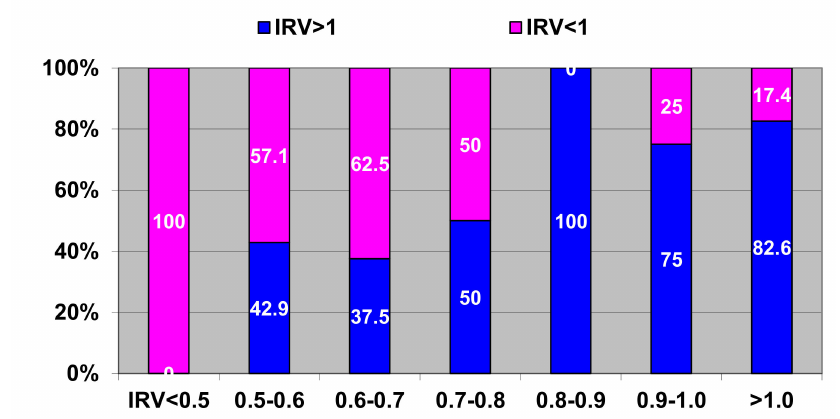
Figure 6. Correlations between pre-operative and long-term post-operative IRV. Horizontal axis—pre-operative IRV; vertical axis—long-term post-operative IRV with respect to threshold value. Blue color–share of post-operative IRV > 1; pink color-share of post-operative IRV <